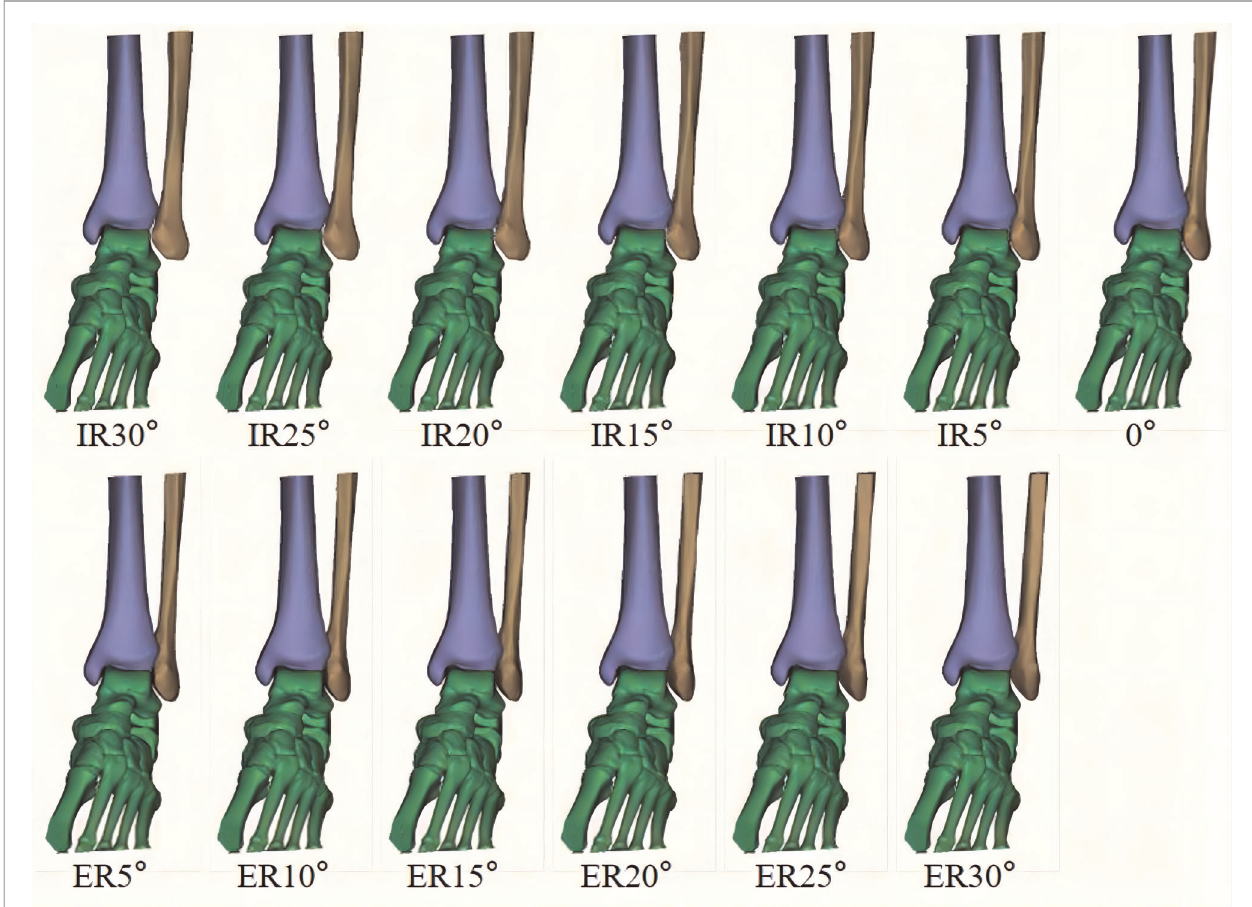
FIGURE 3 | Fibula was rotated both internally and externally along the longitudinal axis to achieve 13 different